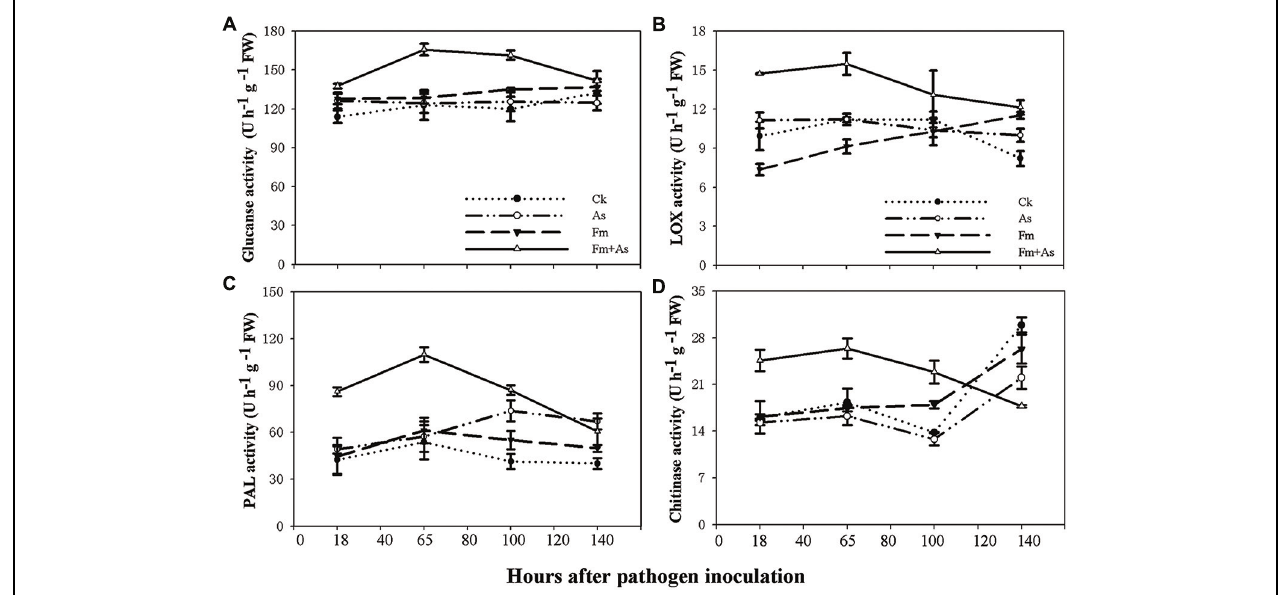
FIGURE 2 | Activity levels of defense-related enzymes in tomato leaves in response to mycorrhizal colonization and pathogen infection. The tomatoes were pre-inoculated with mycorrhizal fungus Funneliformis mosseae and later inoculated with A. solani , the causal agent of early blight disease of tomato. Four defense-related enzymes are β -1,3-glucanase (A) , lipoxygenase (LOX) (B) , phenylalanine ammonia-lyase (PAL) (C), and chitinase (D) . Four treatments included: (1) CK: control plants without pathogen and mycorrhizal inoculation; (2) As: plants inoculated with A . solani only; (3) Fm: plants inoculated with F. mosseae only; (4) Fm + As: plants inoculated with both F. mosseae and A . solani . Values are means ± SE from three sets of independent experiments with three pots per treatment for each set of experiments. Significant differences among treatments were tested at P = 0.05 by Tukey post hoc